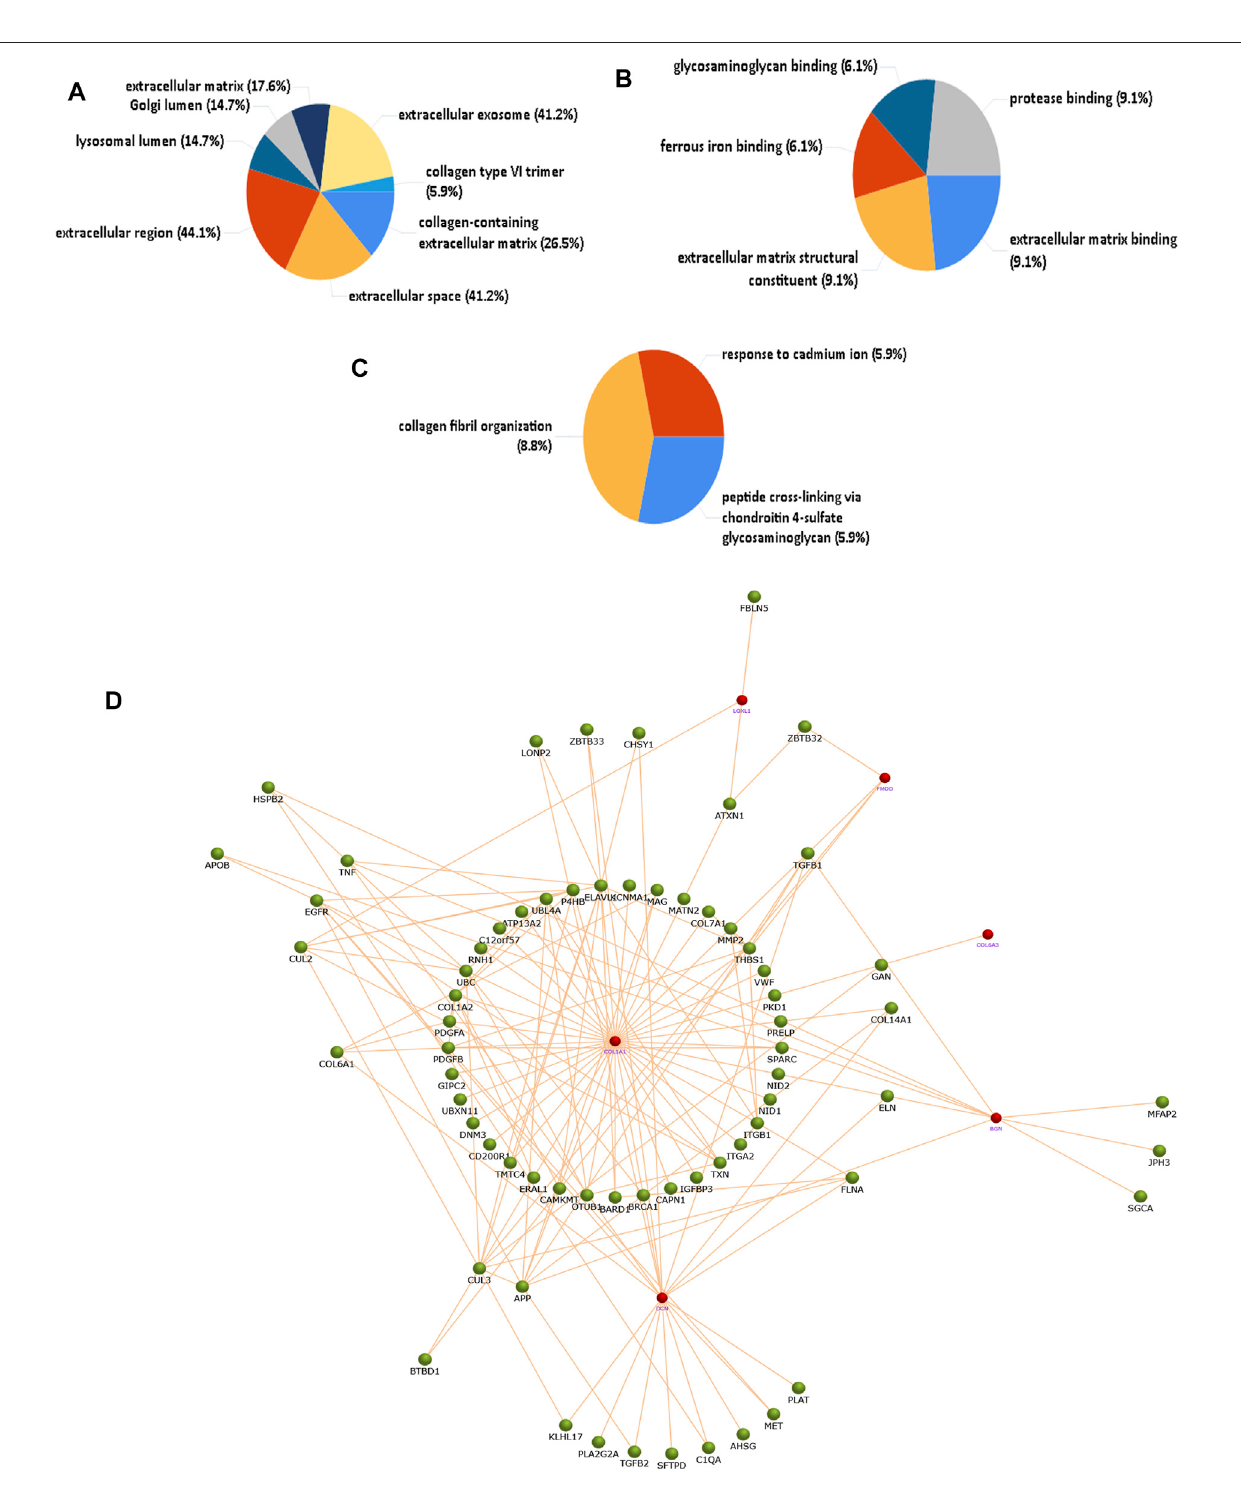
FIGURE 2 | Functional enrichment protein analysis of overexpressed/underexpressed PXG proteins compared to PXF by the FunRich database tool. A total of 27 overexpressed and eight underexpressed proteins were subjected to this analysis. (A) Percentage of the cellular component showing the collagen type-VI trimer more enriched in PXG. (B) Percentage of molecular functions showing glycosaminoglycan binding, ferrous iron binding, and ECM binding more enriched in PXG. (C) Percentageofbiologicalprocessclassi fi cationshowingpeptidecross-linking,collagen fi brilorganization,andresponsetocadmiumionsmoreenrichedinPXG. (D) Protein interaction of neighboring proteins from the UniProt dataset involved in four major pathways showing maximum protein counts including “ ECM proteoglycans, ” “ assembly of collagen fi brils and other multimeric structures, ” “ collagen biosynthesis and modifying enzymes, ” and “ cross-linking of collagen fi brils ” by six important proteins(Col1A1,Col6A3,LOXL1,FMOD,DCN,andBGN).Therednoderepresentsthetargetprotein,andthegreennoderepresentstheneighboringprotein.Col1A1- collagen alpha-1(I) chain, Col6A3-collagen alpha-3(VI) chain, LOXL1-lysyl oxidase homolog 1, FMOD-, DCN-decorin, and BGN-biglycan.